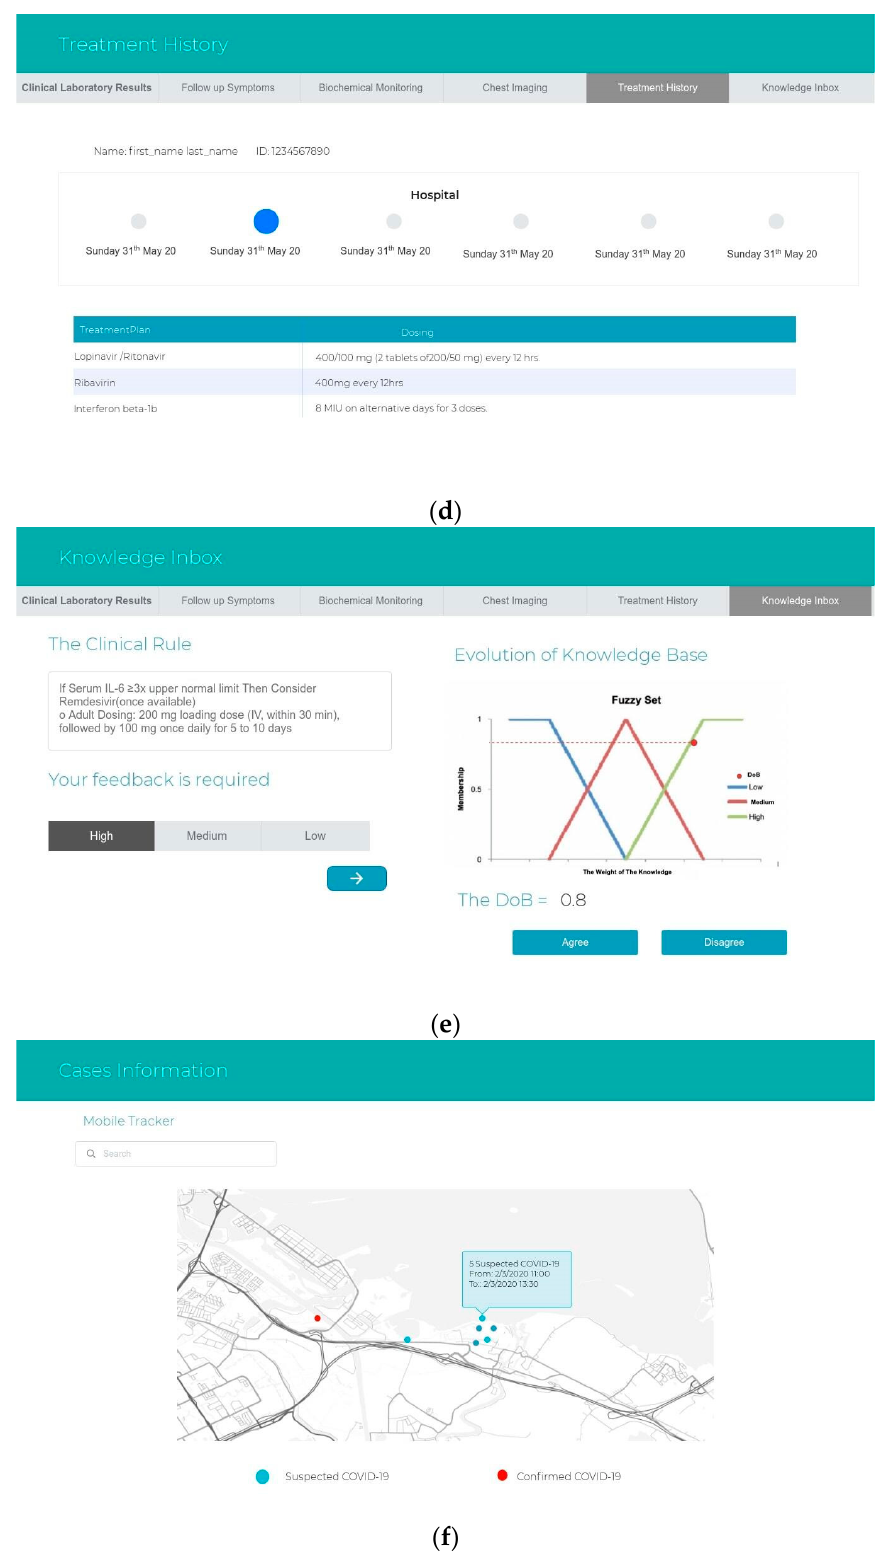
Figure 4. Prototype interfaces for the sub-system. The notification and follow-up system include ( a ) clinical laboratory results, ( b ) symptoms, ( c ) chest images, ( d ) treatment history, ( e ) the adaptive learning system and the new clinical rules in the knowledge inbox, and ( f ) the mobile tracker system.